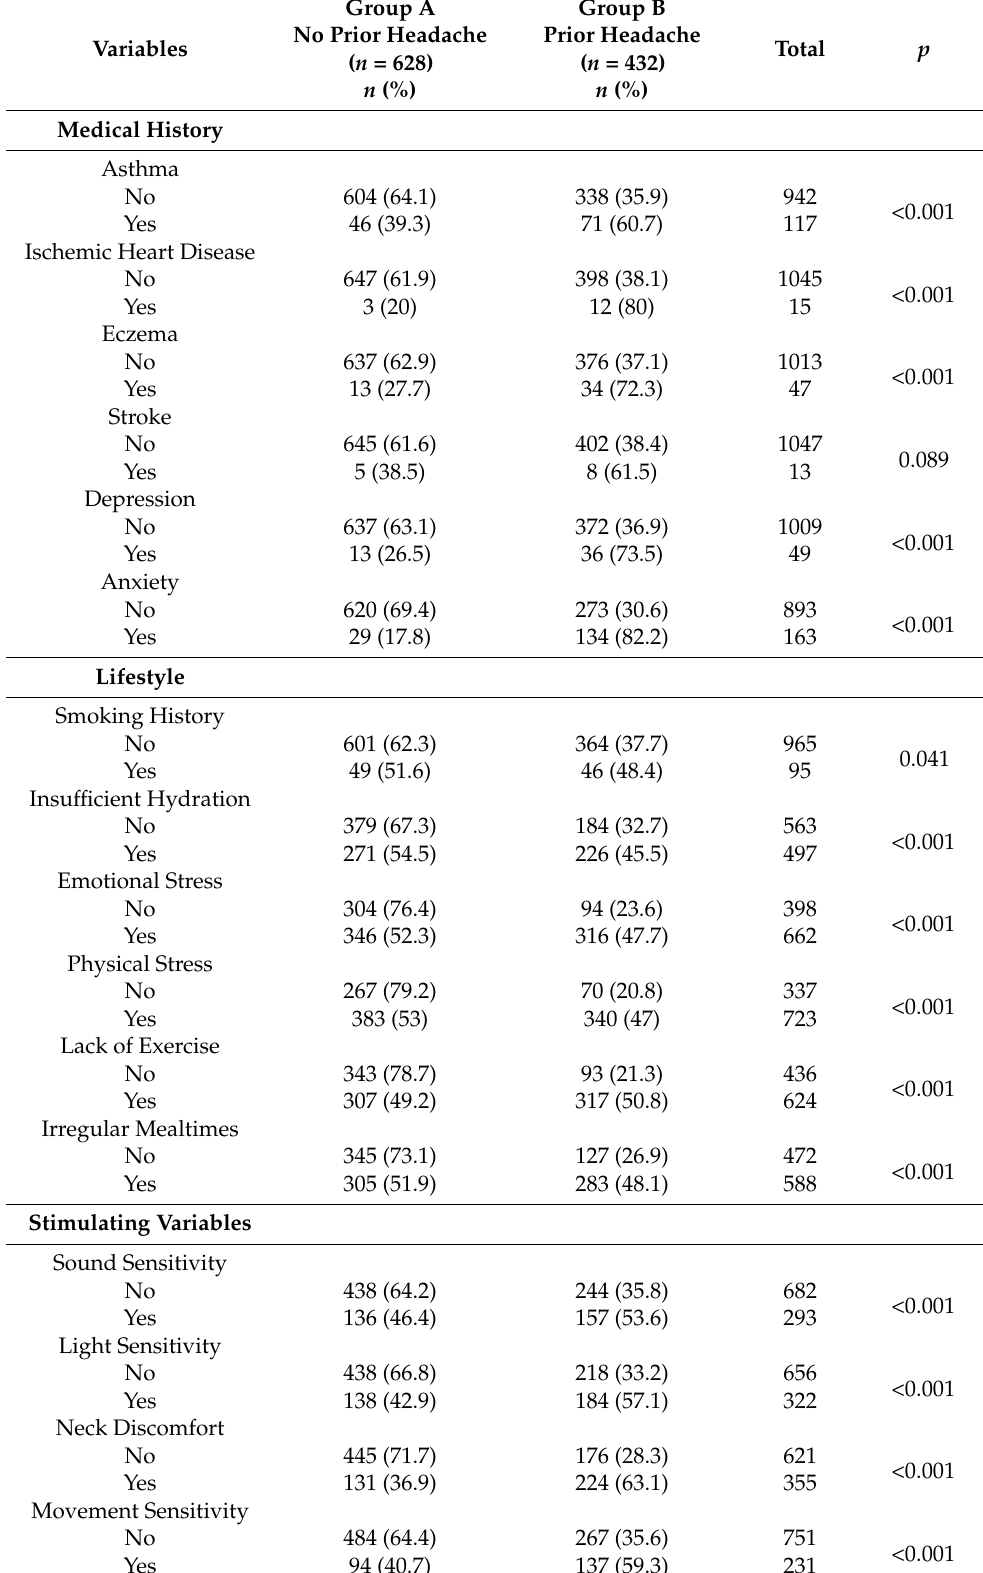
Table 2. Descriptive Statistics of Study Variables and Comparison of Healthcare Providers with Headache and No Headache before the COVID-19 Pandemic using the Chi-Square